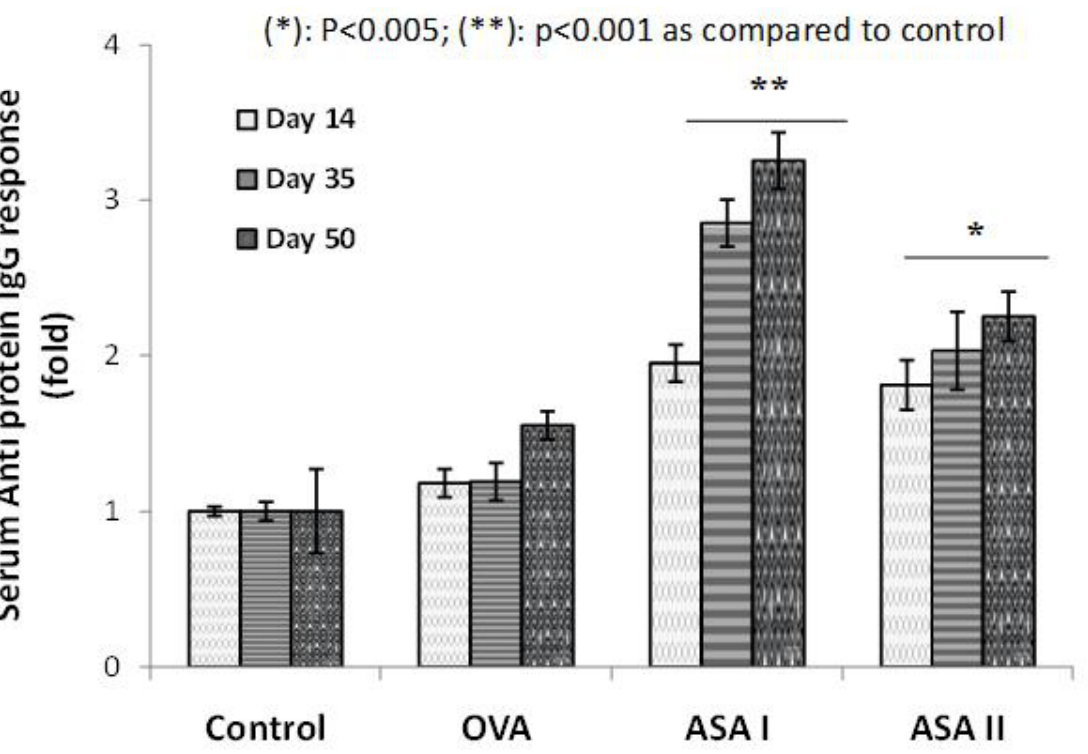
Figure 4. Mucosal immune (anti-OVA and anti-lectin) IgG response analyzed in the sera obtained from BALB/c mice after intranasal administration of antigens. Antigens (100 µ L/well) were coated overnight, washed, blocked with BSA, and incubated with test serum. Detection of IgG antibody response by using goat anti-mouse IgG-alkaline phosphatase-conjugated antibody and p -nitrophenyl phosphate (PNPP) substrate. The IgG response is represented as a fold increase in absorbance over control, wherein the absorbance of the control was taken as 1. Coated antigen amount is 10 µ g/well; primary antibody source, mice sera dilution was at1:10 (volume, 100 µ L); * p < 0.005 vs. control; ** p < 0.001 vs. control. Each value is represented as mean ± S.D. ( n = 3).